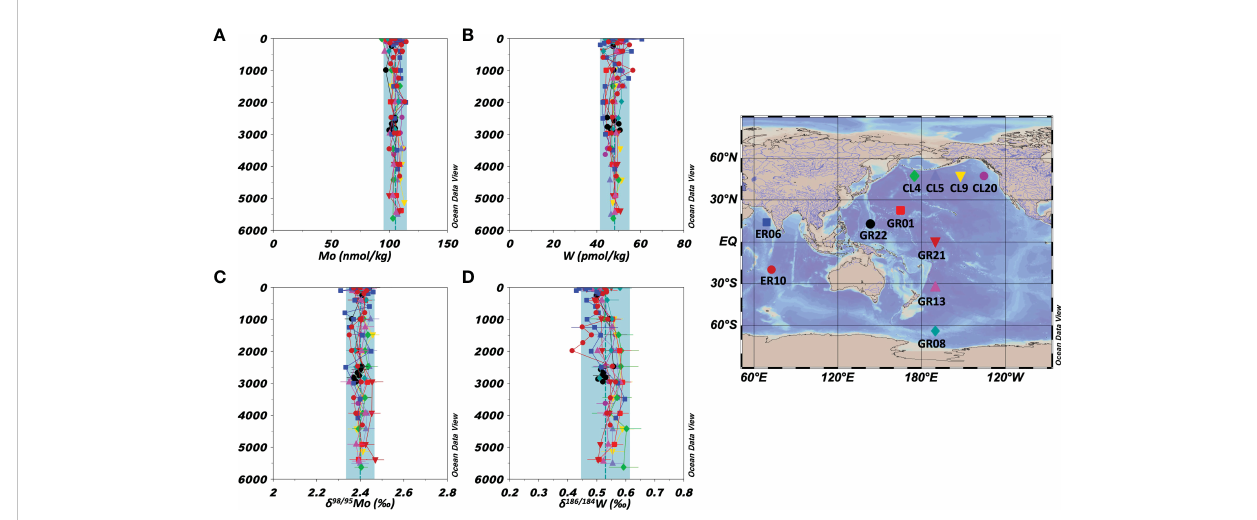
FIGURE 2 Vertical pro fi les of the concentrations and isotope ratios of Mo and W in the open oceans (the Paci fi c and Indian Oceans). The data symbols are consistent with the sampling point symbols on the map. The error bar shows a standard deviation ( ± 1sd). The blue columns show ranges of ave ± 2sd for all oceanic samples. (A) : Mo concentration. (B) : W concentration. (C) : d 98/95 Mo. (D) : d 186/184